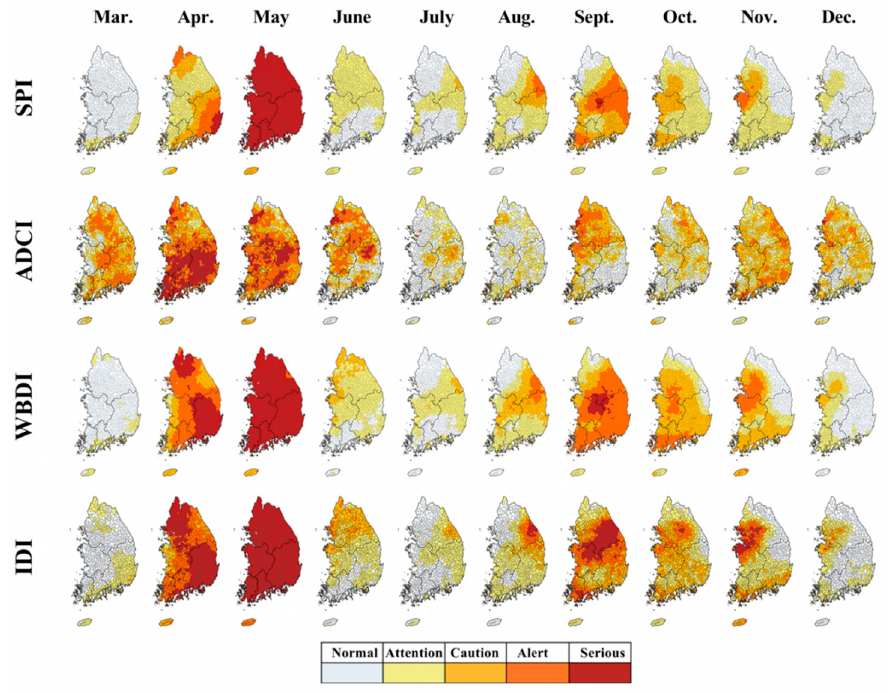
Figure 5. Spatial change of each drought index: SPI, ADCI, WBDI, and IDI (integrated drought index) for the 2001 drought.